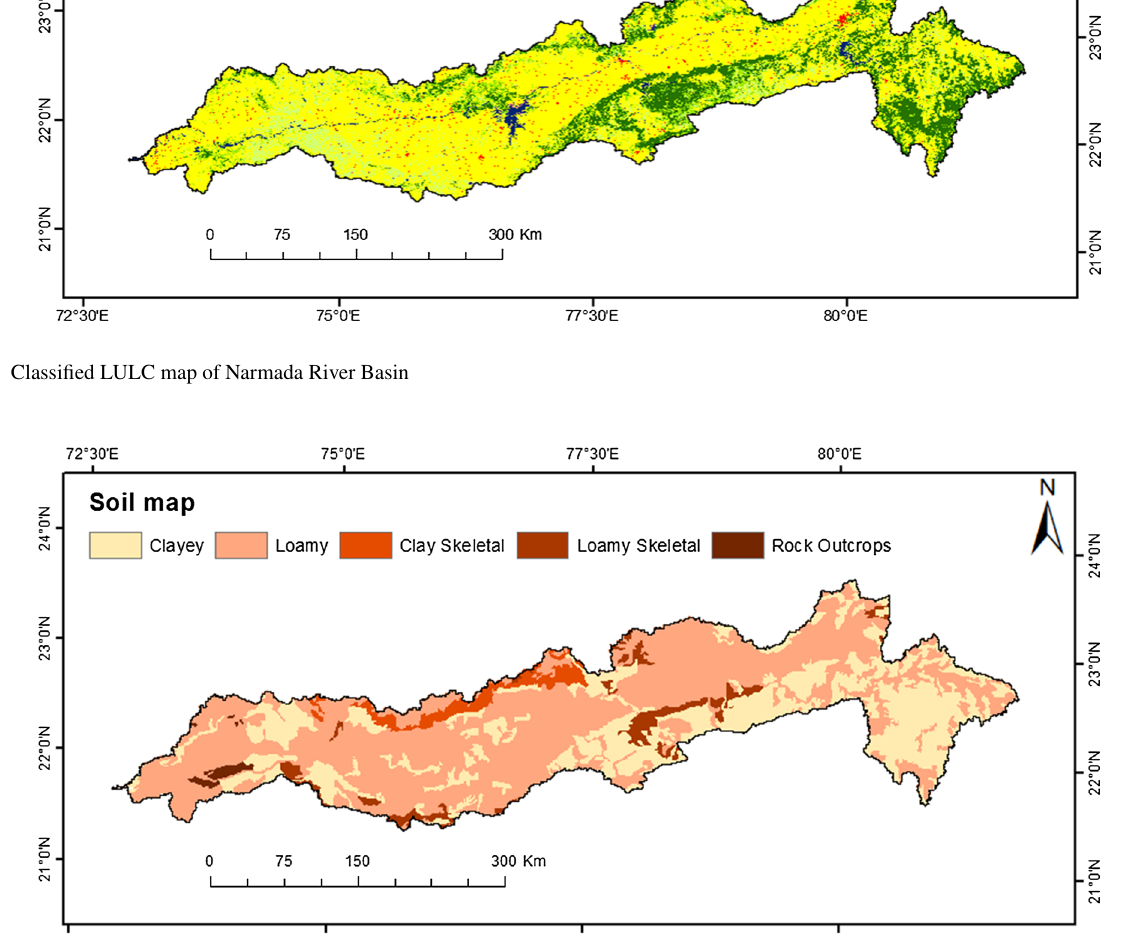
Fig. 9 Classified soil map of Narmada River